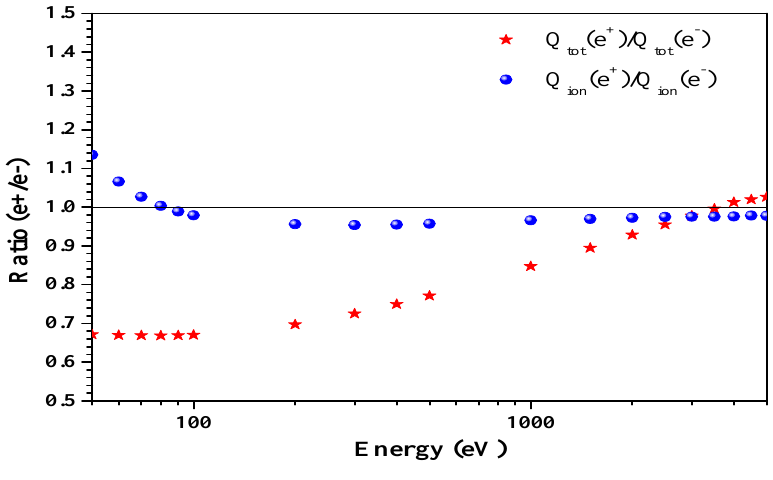
Figure 10. Ratio of cross section for e − /e + -propene interaction